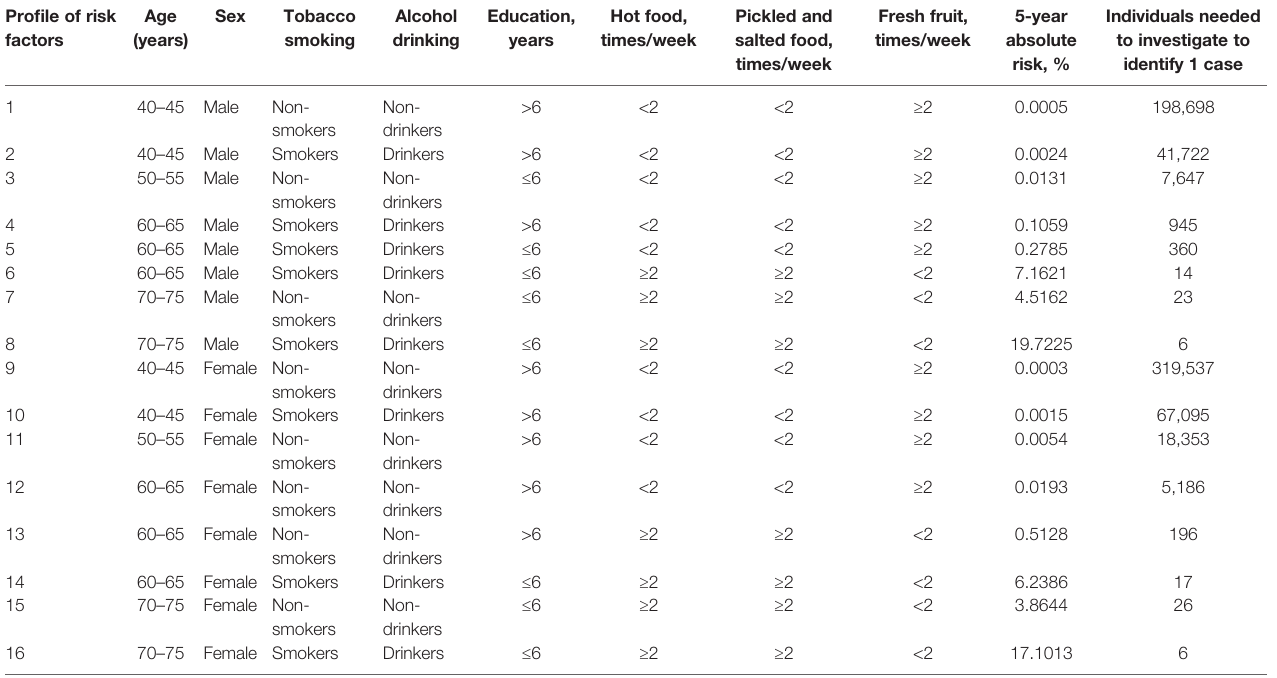
TABLE 2 | Estimated 5-year absolute risk of ESCC in the Chinese population from high prevalence regions with different risk factors.